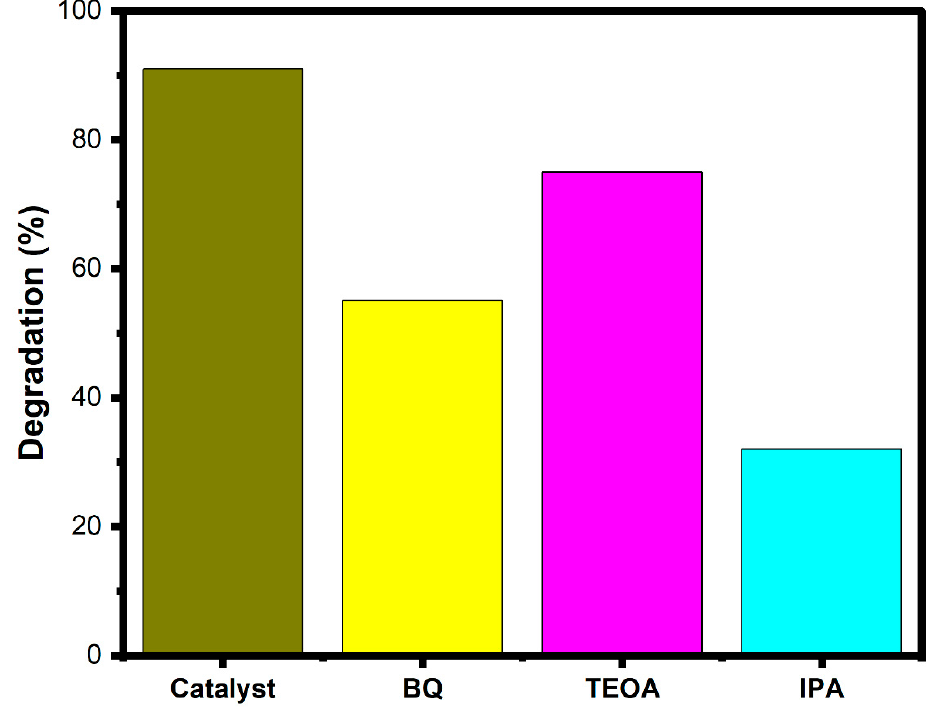
Figure 11. Quenching